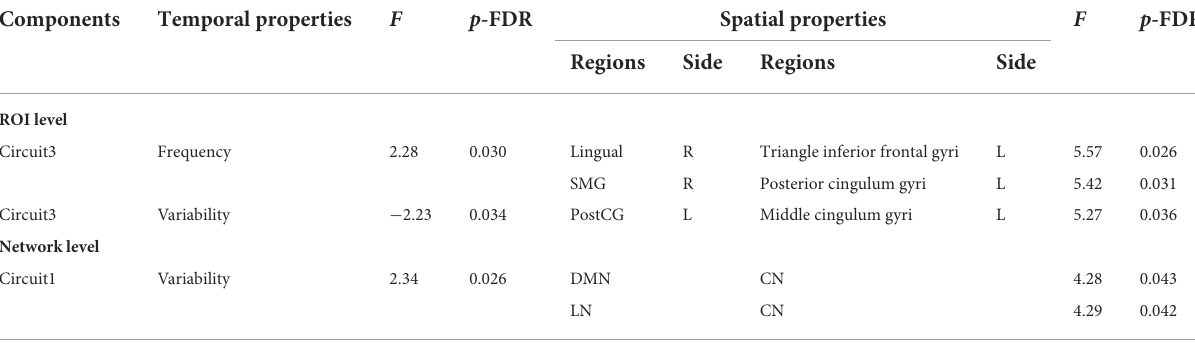
TABLE 4 PSA-related differences in dynamic functional connectivity during EA stimulation.